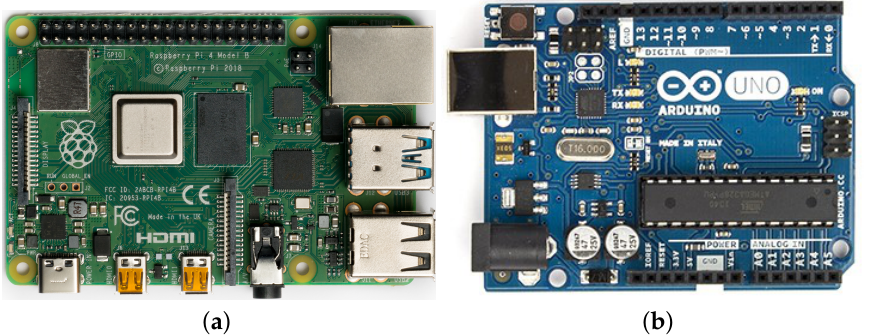
Figure 2. Possible platforms for multi-secret steganography system: ( a ) Raspberry Pi 4 Model B (Laserlicht/Wikimedia Commons/ ); ( b ) Arduino Uno (R.hampl/Wikimedia Commons/